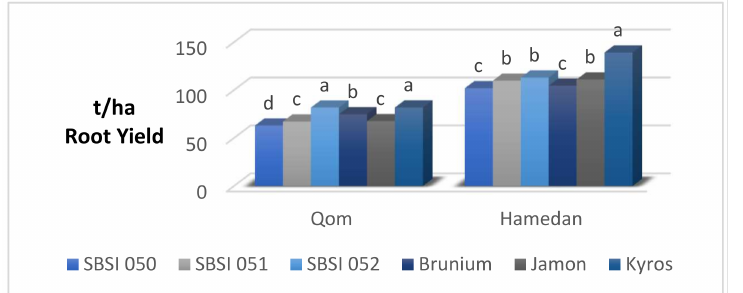
Figure 1. The interaction effect of location × genotype on root yield. Means followed by the same letter(s) is/are not significantly differ at 5% level of probability.